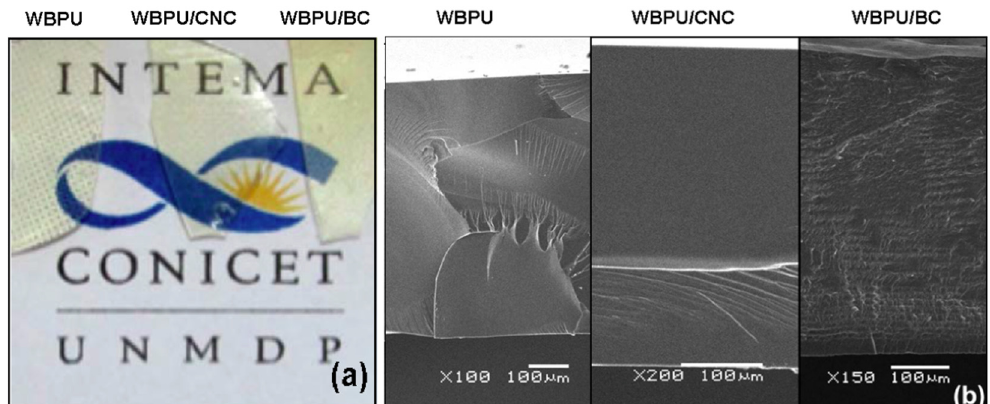
Figure 5. ( a ) Digital photography of the films; ( b ) SEM images of the fracture surface of the films. In both cases, the images correspond to neat WBPU (left), WBPU/CNC (center), and WBPU/BC (right) composites.